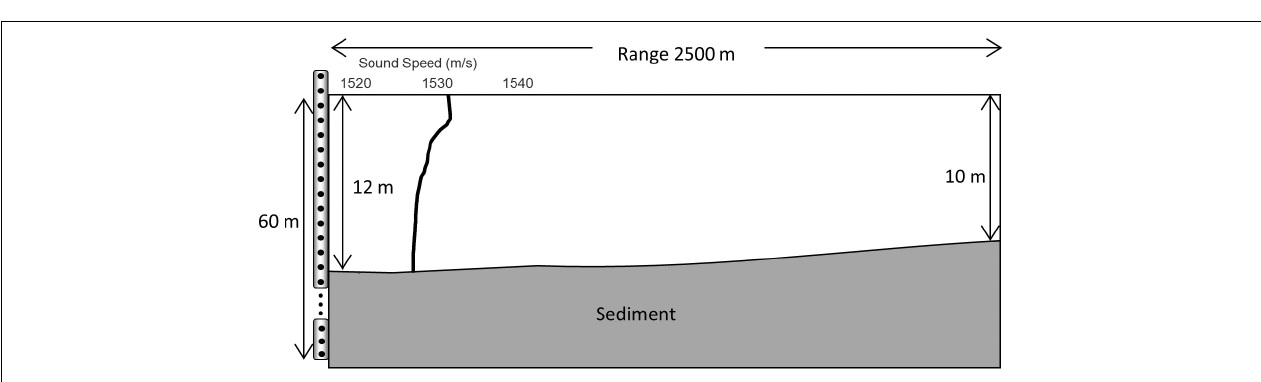
FIGURE 8 | Bathymetry of the site and the geometry showing virtual acoustic point sources. The thick solid line in water column represents the sound-speed profile with